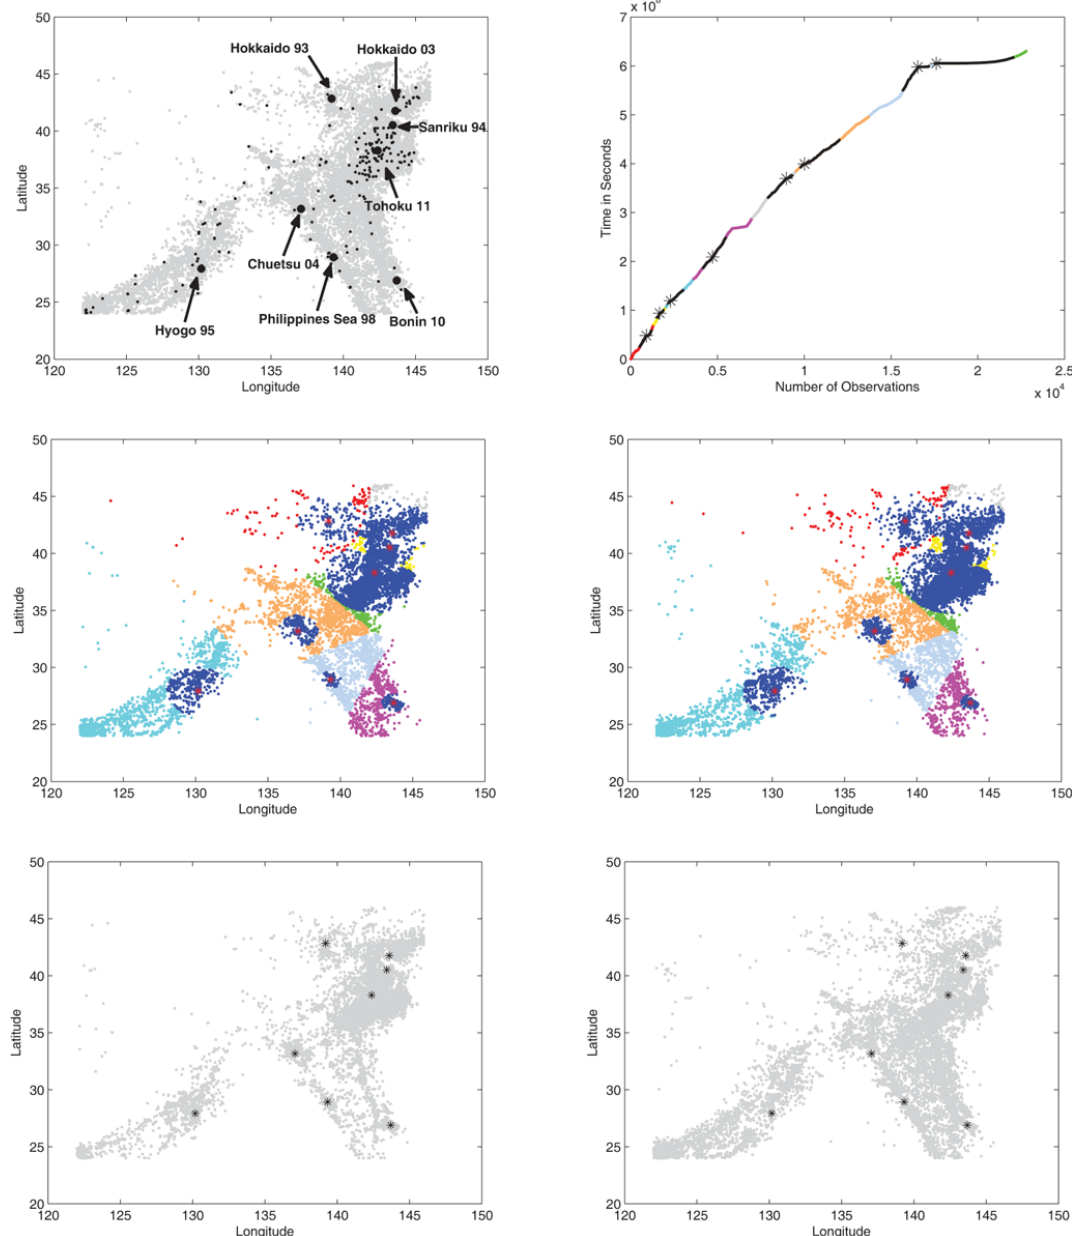
Fig. 9. Tri-stage cluster identification of the seismic catalog of Japan: (top left) location of mainshocks, designated by black asterisks, and location of events M > 6, designated as black dots, 1992–2011; (top right) output of time zone clustering; (middle left) output of background and clustered coordinate zone for C 1; (middle right) output of background and clustered coordinate zone for C 2; (bottom left) events classified as aftershocks; (bottom right) events classified as